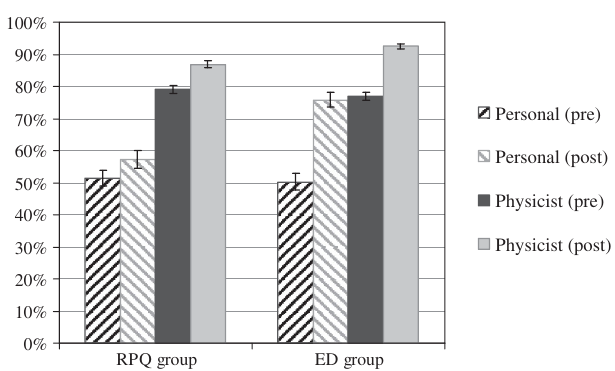
FIG. 1. Overall favorable scores on pre-CLASS and post- CLASS test for RPQ group and ED group.